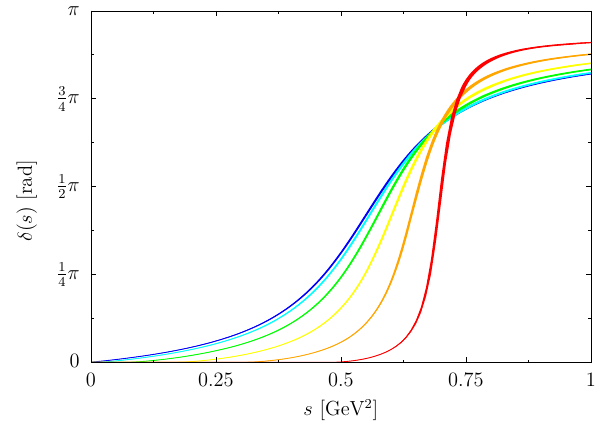
¯ M ¯ M ¯ M π (cyan), π (green), 3 2 π (yel- 2 ¯ M π (red). The error bands result from the 2